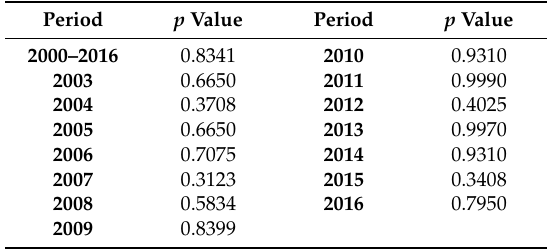
Table 16. Wilcoxon Test results ( p values)—five-year growth